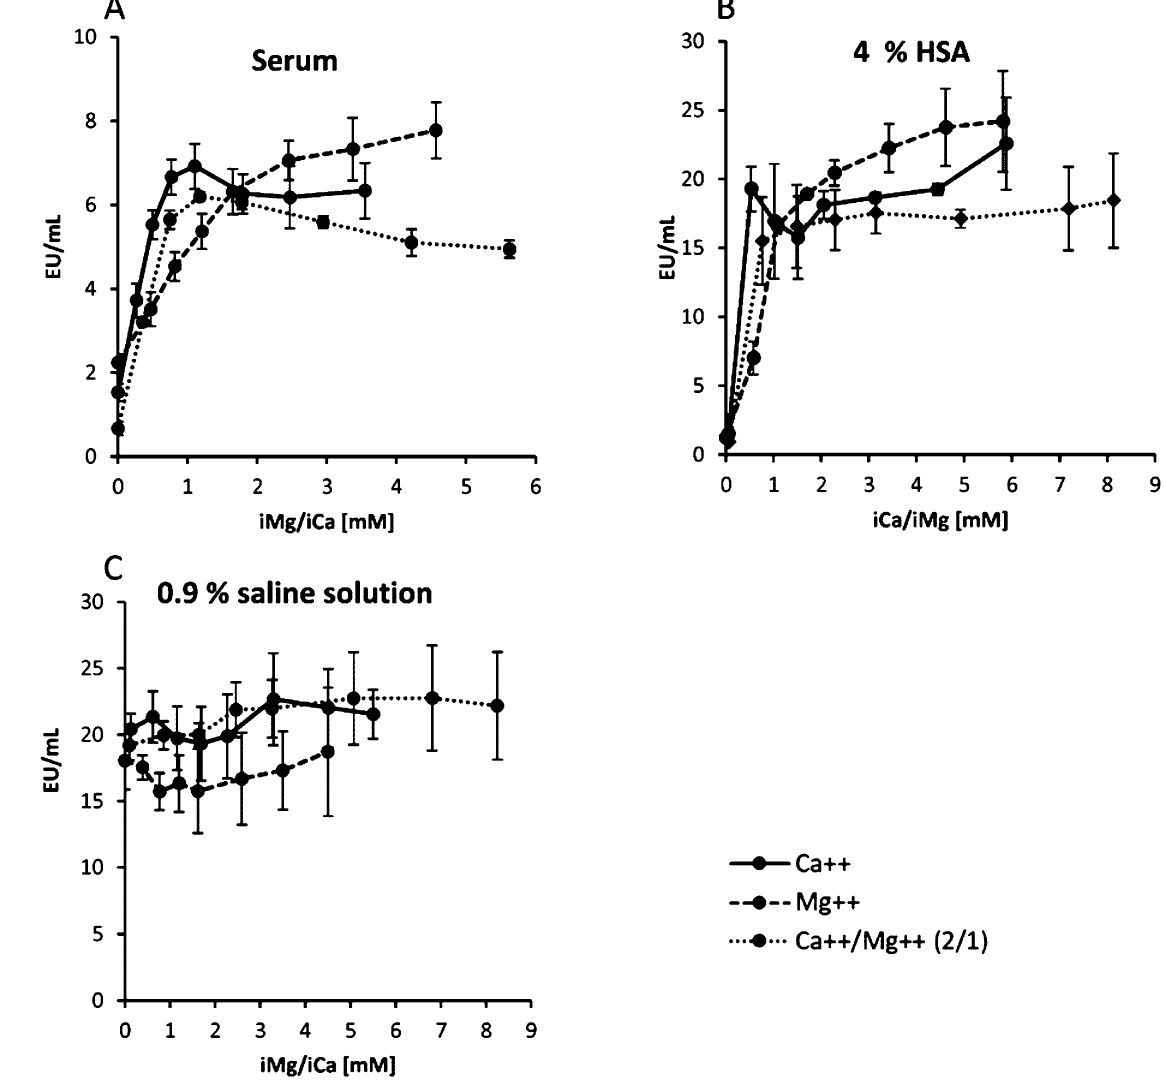
Figure 7. Endotoxin activity in serum ( A ), 4% HSA solution ( B ) and aqueous protein-free saline solution ( C ) as a function of divalent cation levels. The three media were spiked with increasing concentrations of divalent cations (iCa, iMg or iCa/iMg in 2:1 ratio). The x-axis shows the sum of iCa + iMg value in mM. Afterwards, the recovery of 5 ng/mL LPS ( E. coli ) was determined by LAL test. Mean ± standard deviation of three independent experiments are